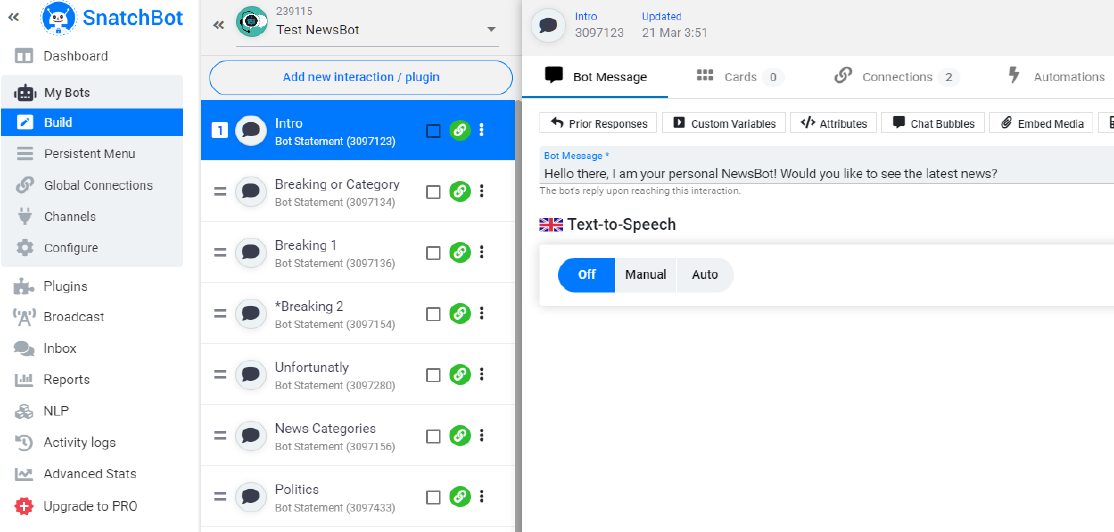
Figure 3. The chatbot creation interface of SnatchBot.